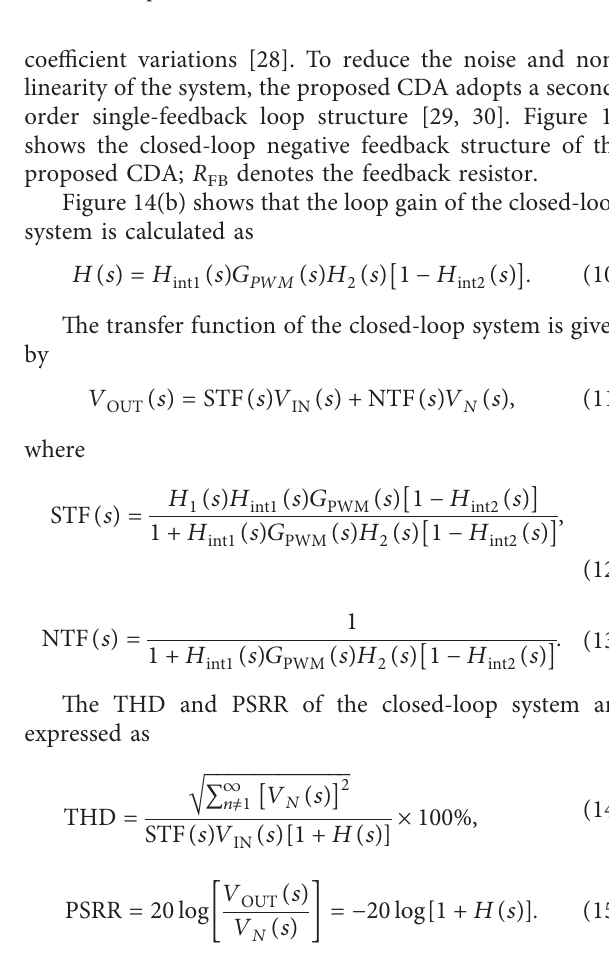
Figure 11: Rail-to-rail differential comparator.